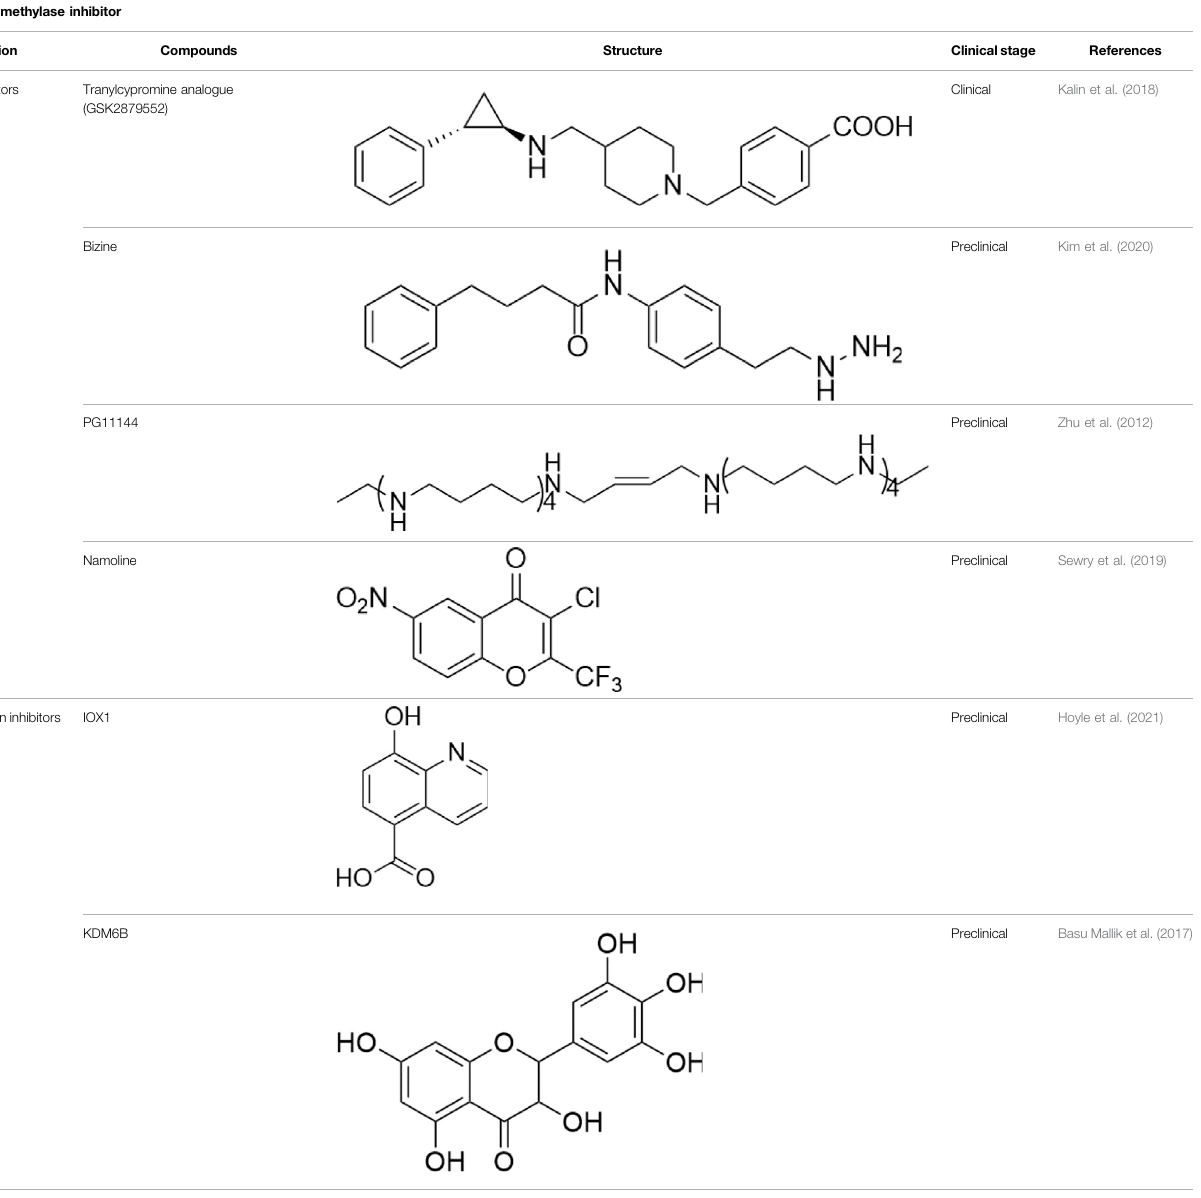
TABLE 4 | A list of histone demethylase inhibitors under different phases of clinical trial and their indication. Histone demethylase